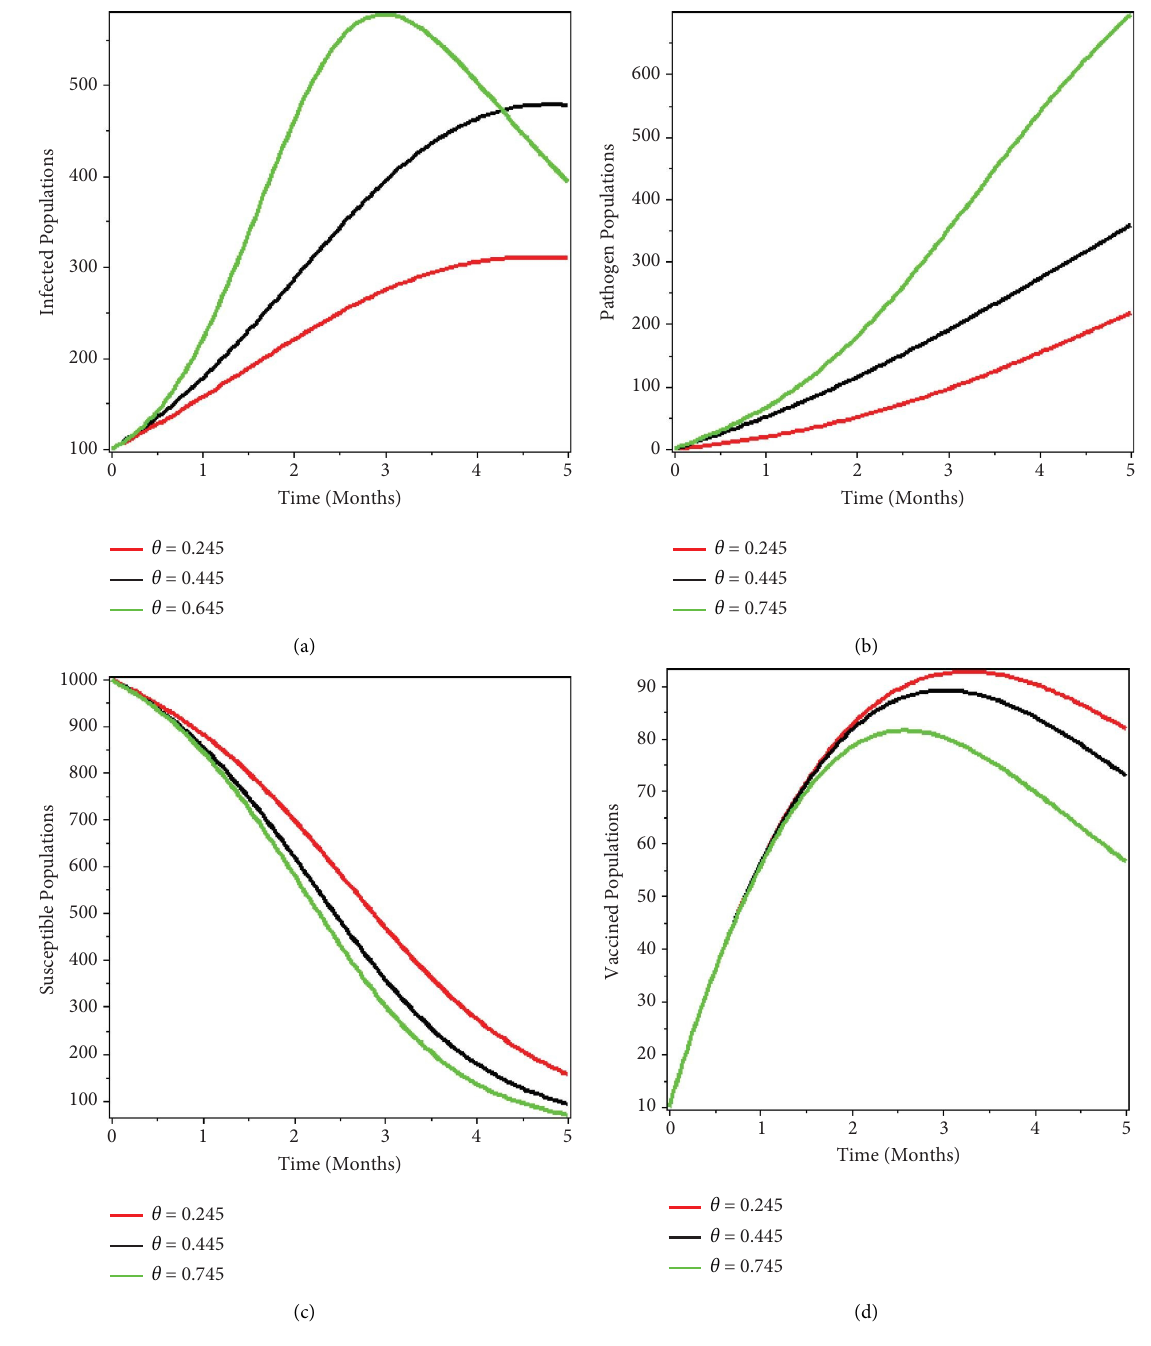
Figure 6: Vaccinated population with diferent values of θ